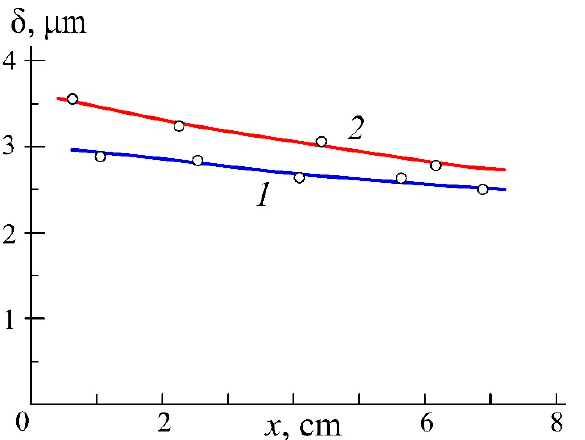
Figure 6. Dependence of the coating thickness on the inner (1) and outer (2) surfaces of the hollow cylinder on the distance from its end.